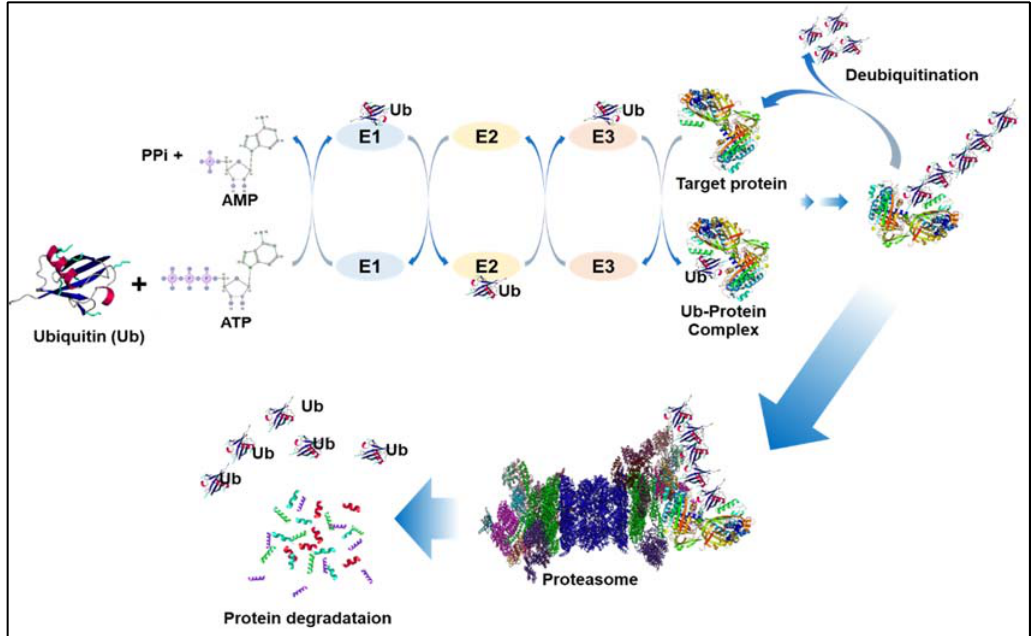
Figure 2. The ubiquitination processes. Ubiquitin (Ub) is added to the selected substrates in three phases, each necessitating the use of three enzymes: E1, E2, and E3. Step 1: The ubiquitin-activating enzyme E1 activates ubiquitin in an ATP-dependent manner. Step 2: Ubiquitin is subsequently transported to one of numerous types of E2, the ubiquitin conjugating enzyme. Step 3: The attachment of ubiquitin to the protein substrate is mediated by one of many E3s. The 26S proteasome recognizes polyubiquinated proteins and degrades them. Small peptides and reusable free ubiquitin are produced by their cleavage. Deubiquitination catalyzes the removal of Ub from substrate proteins.